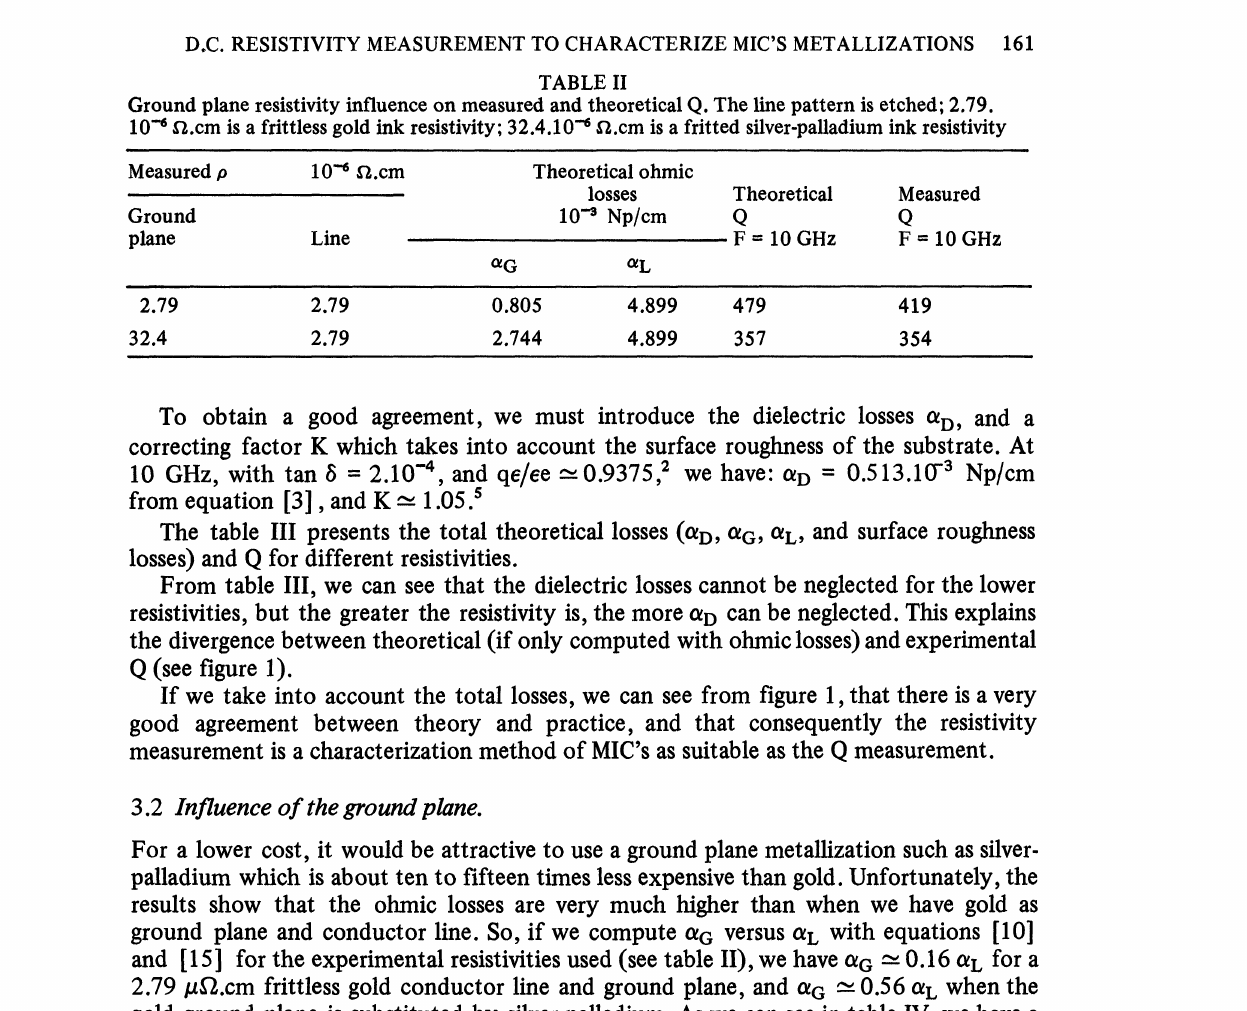
TABLE II Ground plane resistivity influence on measured and theoretical Q. The line pattern is etched; 2.79. 10 .cm is a frittless gold ink resistivity" 32.4.10 s2.cm is a fritted silver-palladium ink resistivity